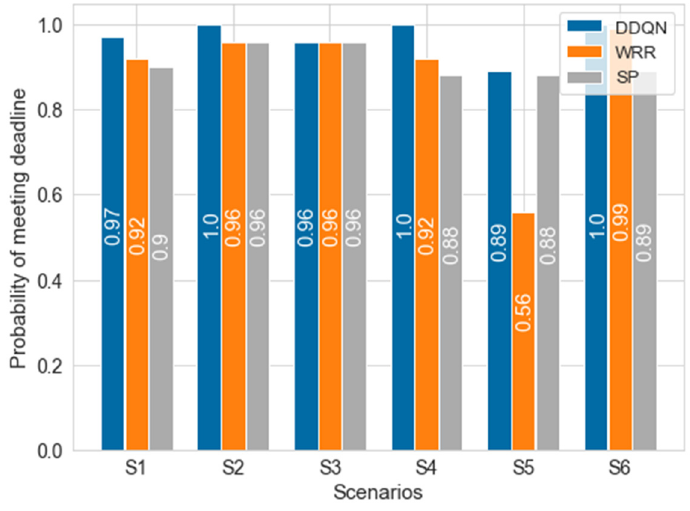
Figure 12. Probability of meeting the deadline in each scenario.